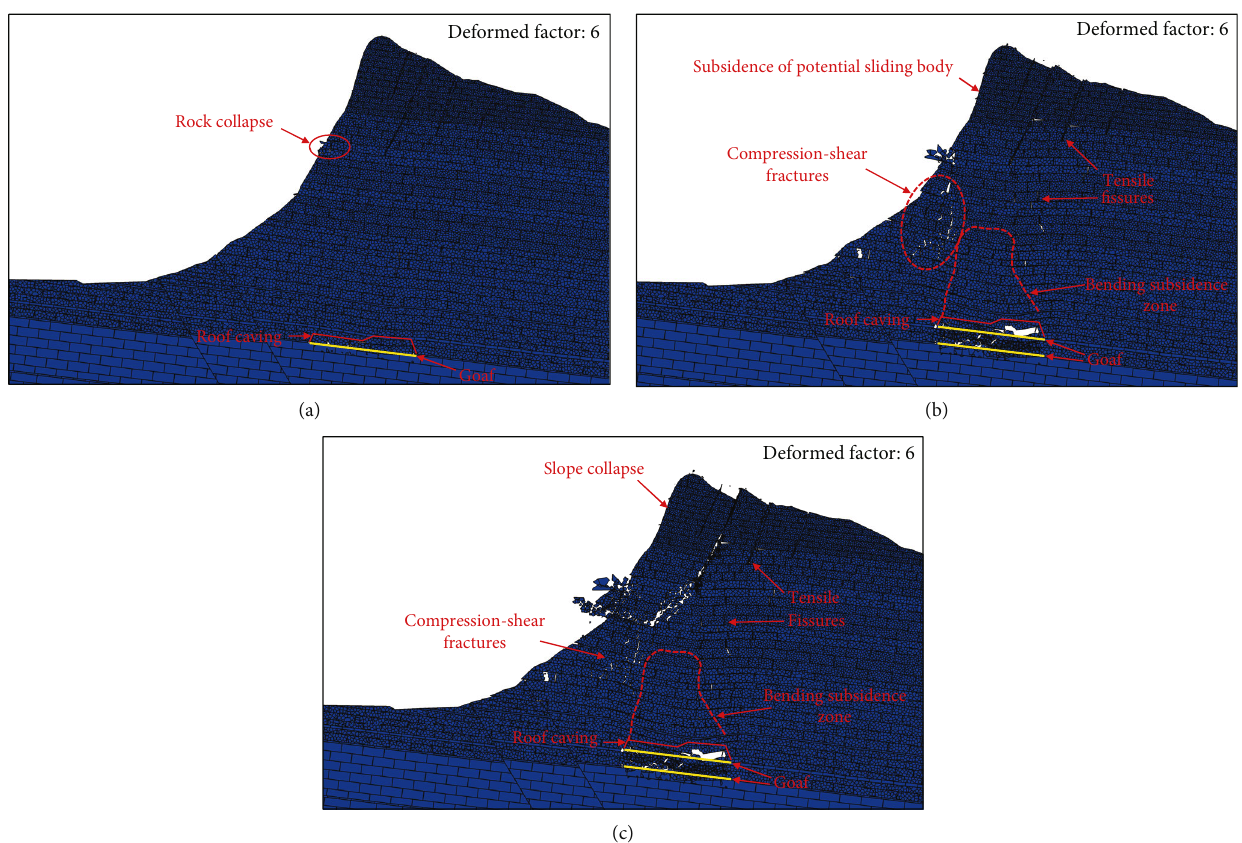
Figure 11: The slope failure characteristics after coal seam mining and heavy rainfall: (a) No. 14 coal seam mined out; (b) No. 10 coal seam mined out; (c) after heavy